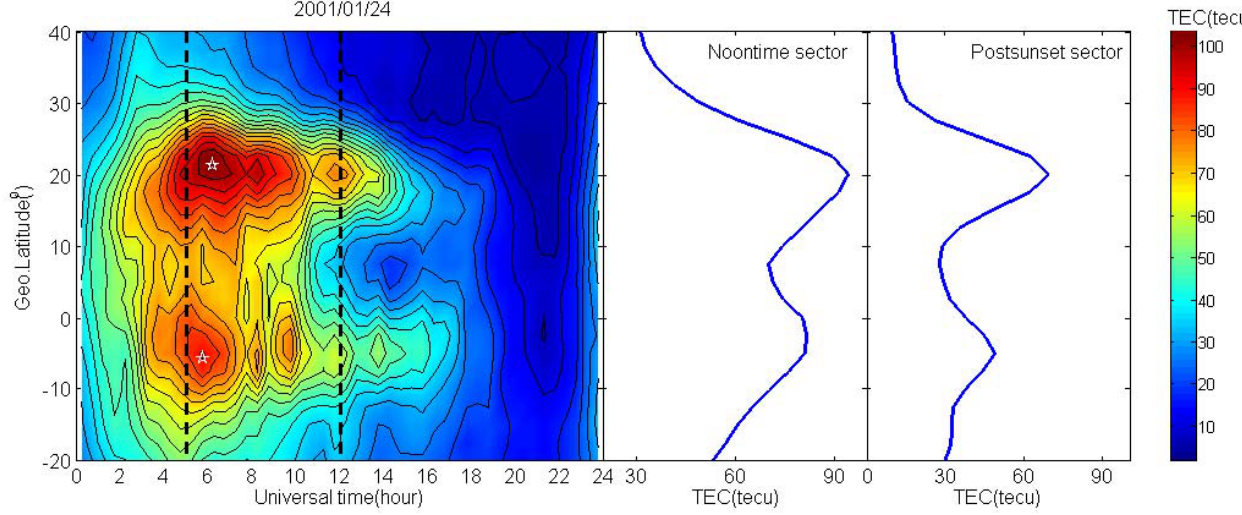
Fig. 2. Schematic TEC contour map in the UT/latitude frame (left panel) on 24 January 2001. The pentagons denote the position of daily Figure 2 . Schematic TEC contour map in the UT/latitude frame (left panel) on January 24 peak value of EIA for northern crest and southern one, respectively. The vertical dashed lines indicate the local time 13:00LT and 21:00LT (LT=UT+8). The corresponding TEC profiles are given in the right 2001. The pentagons denote the position of daily peak value of EIA for northern crest and southern one respectively. The vertical dashed lines indicate the local time 1300 LT and 2100 LT (LT=UT+8). The corresponding TEC profiles are given in the right panels.